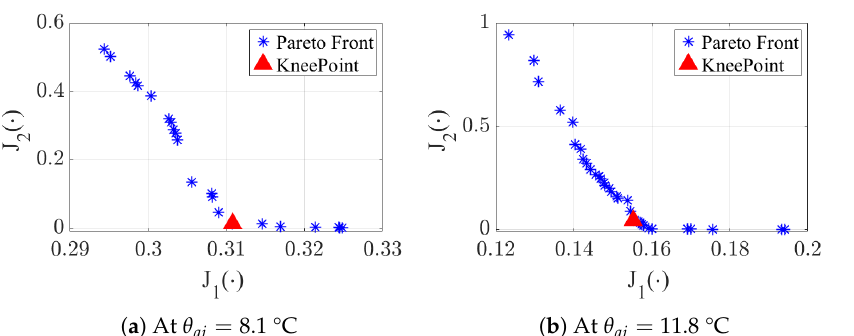
Figure 10. Pareto optimal fronts generated at minimum (8.1 °C) and maximum (11.8 °C) outside temperatures θ ai recorded during winter.